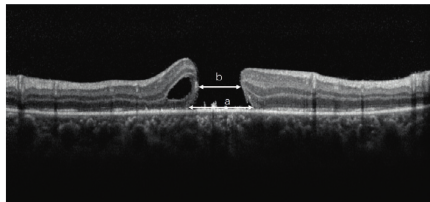
Figure 1: The hole basal diameter (a) was measured as the hole diameter at the level of the retinal pigment epithelium. The hole minimum diameter (b) was measured as the minimum inner di- ameter of the